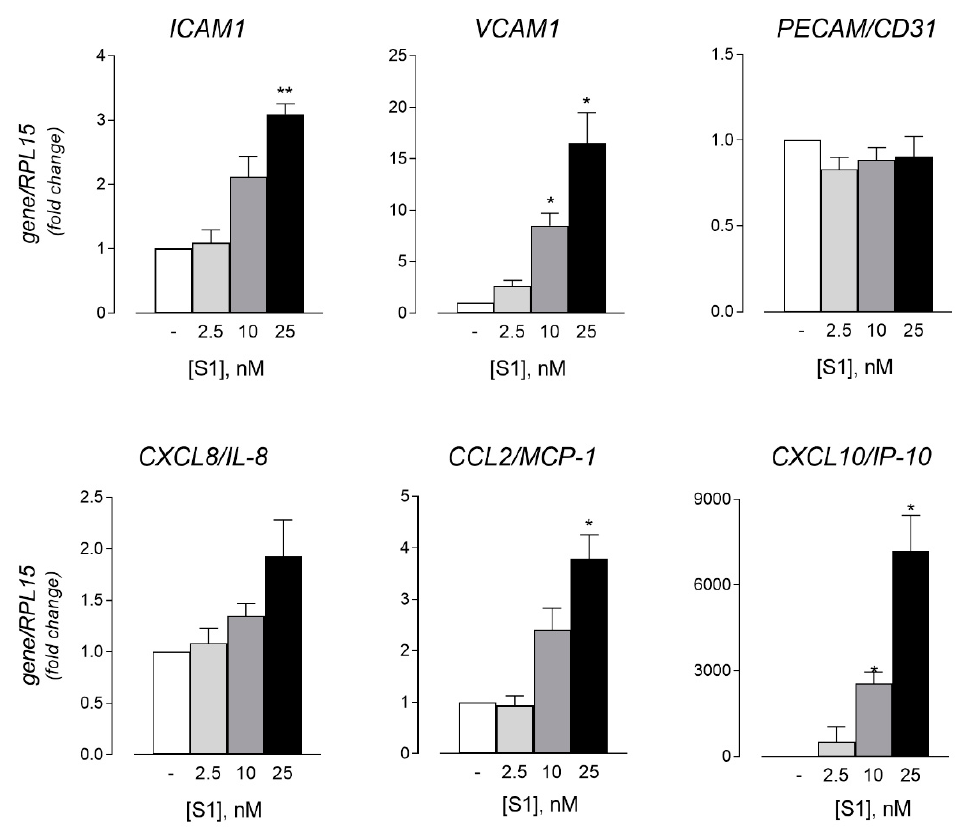
Figure 3. HLMVEC were incubated for 6 h in the absence (-) or in the presence of the indicated concentrations of SARS-CoV-2 spike protein supplemented with 2 µg/mL Polymyxin B (S1). The expression of the indicated genes was then measured by means of RT-qPCR, normalized for that of the housekeeping gene RPL15, and expressed relative to untreated control cells (=1). Data are means ± SEM of three experiments, each performed in duplicate. * p < 0.05, ** p < 0.01 vs. none (-) with “one- sample t -test”.